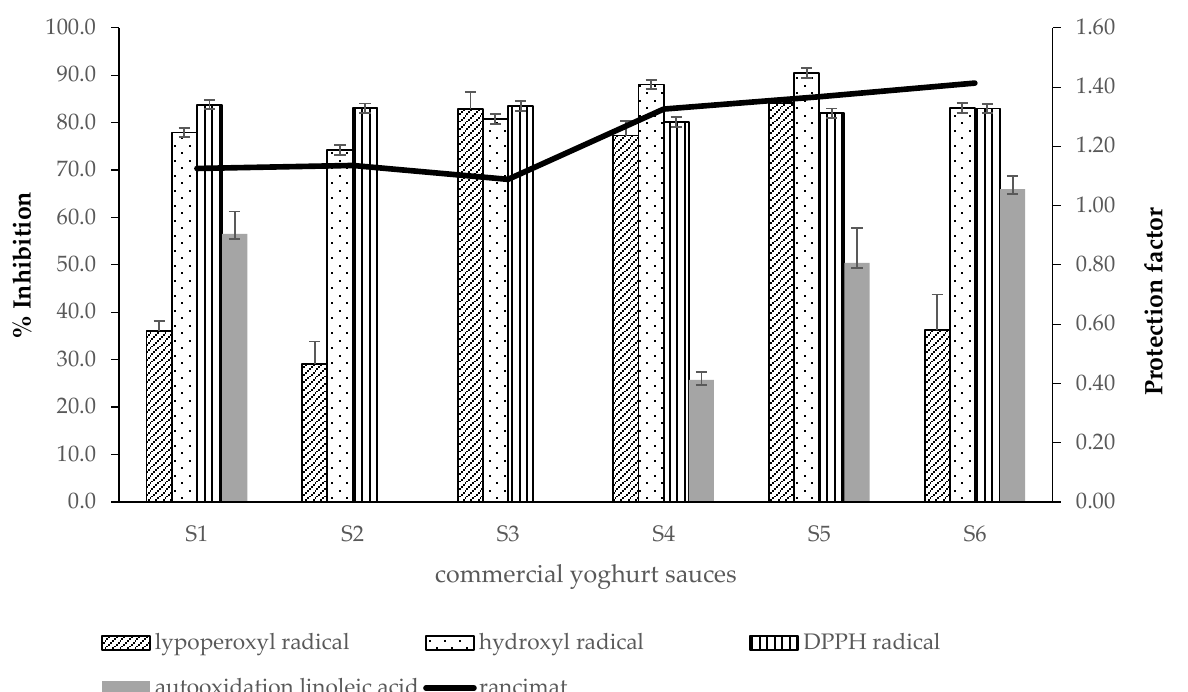
Figure 1. Average ( n = 3) antioxidant activity of six commercial yoghurt sauces evaluated using different assays (lipid peroxidation, hydroxyl and DPPH radical scavenging, autooxidation linoleic acid and Rancimat test).